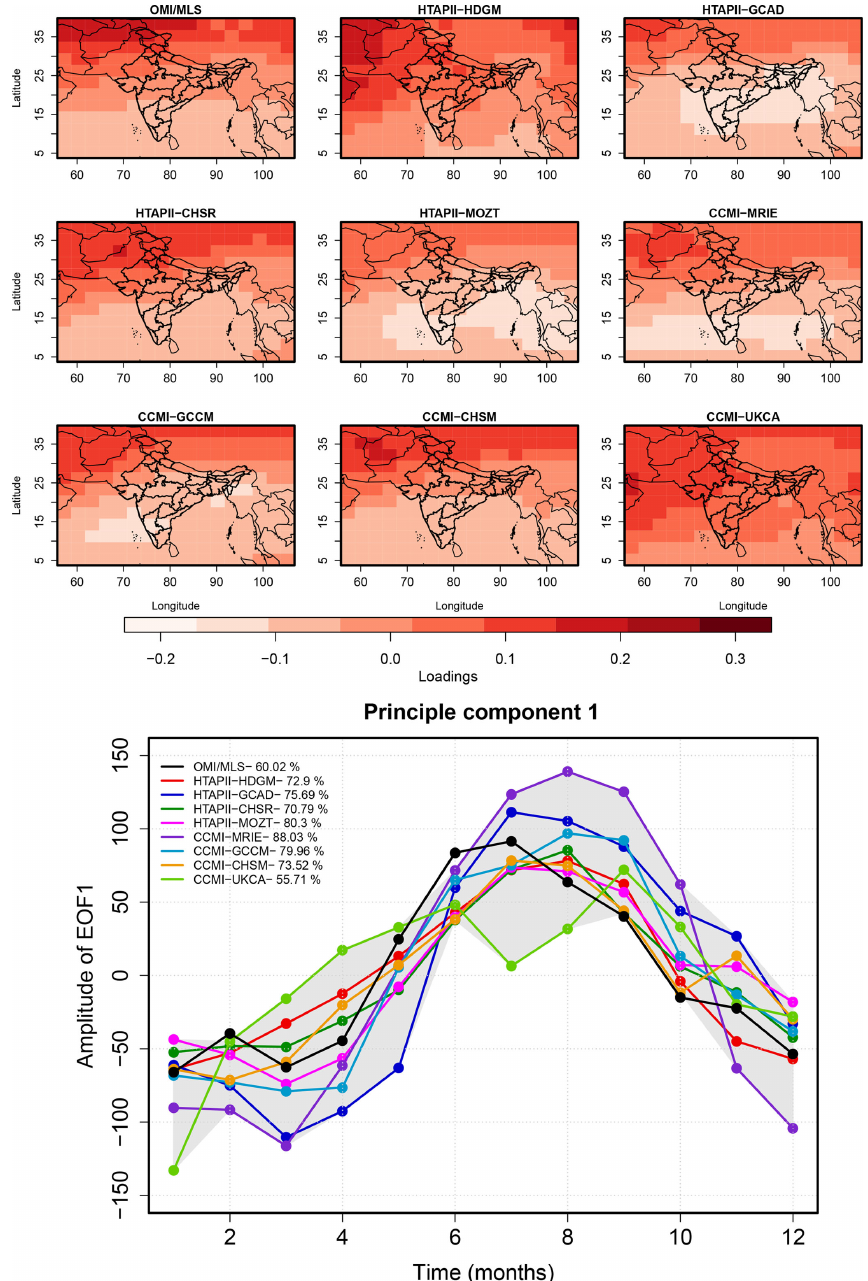
Figure 12. (a) Dominant spatial pattern (i.e. EOF1), which explains the maximum variance in the tropospheric ozone column. (b) Time series of the amplitude of EOF1 (PC1) with the values of accounted variance by the EOF1 in the legend for each